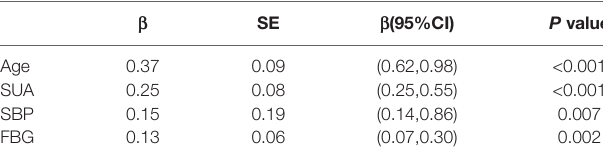
TABLE 3 | Multiple linear regression analysis of CIMT as dependent